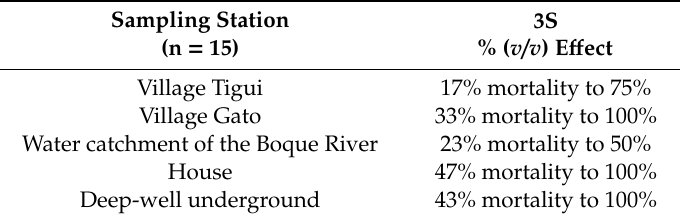
Table 2. Results of bioassay with Daphnia